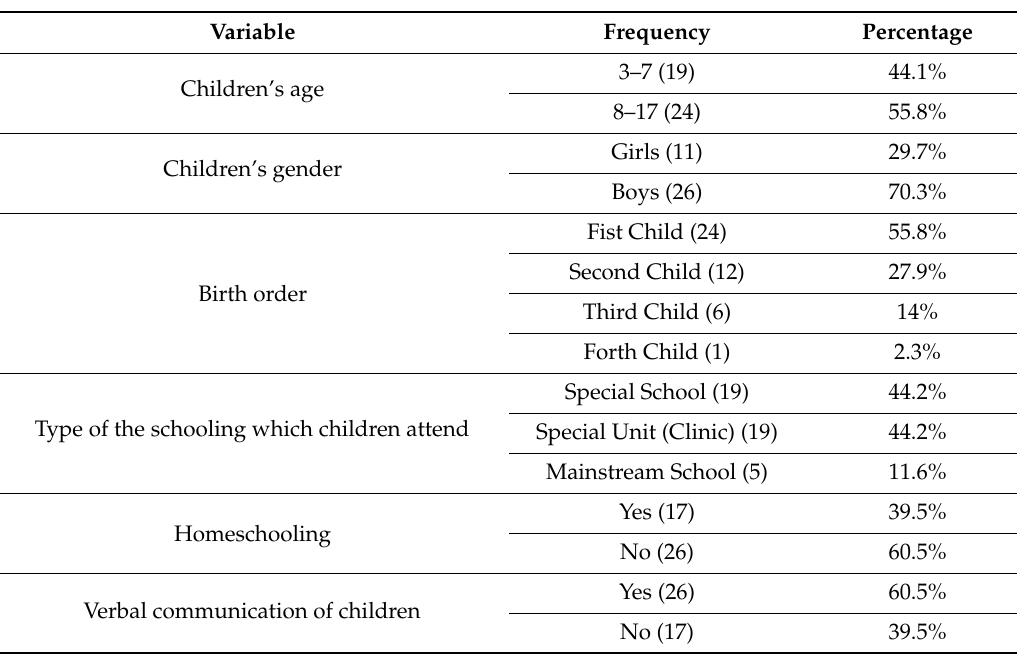
Table 2. The children demographic